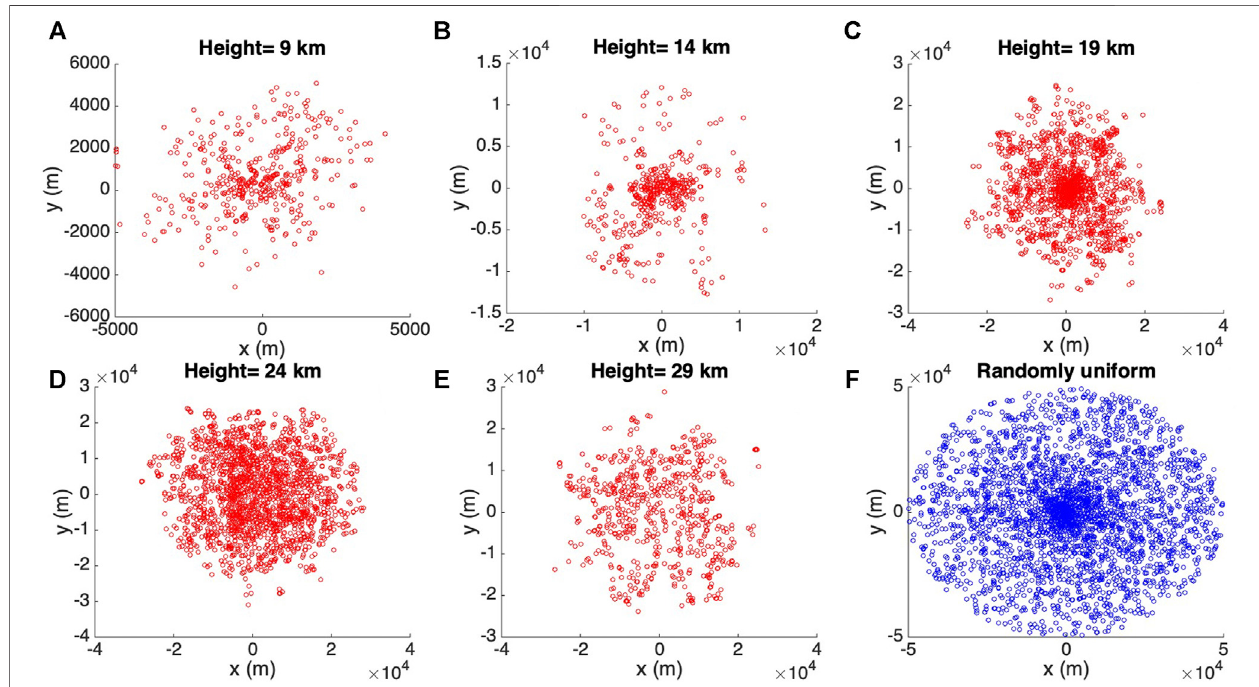
FIGURE 11 | Horizontal distribution of ash particles (tracers) on a cross section of initial ash cloud. Puff assumes a randomly uniform distribution of ash particles within a circle, as shown by blue dots in (F) . All other fi gures show the ash particle distribution of initial ash clouds created by Plume-SPH at different elevations.